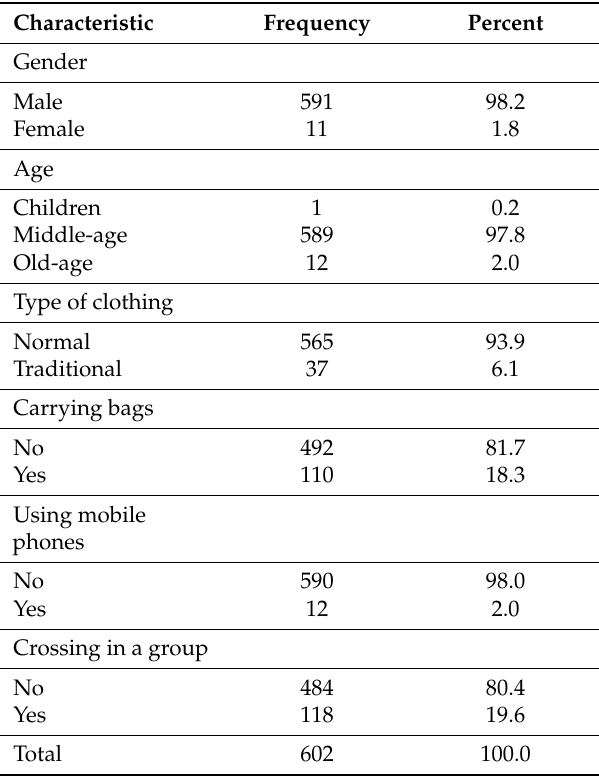
Table 1. Summary of pedestrian